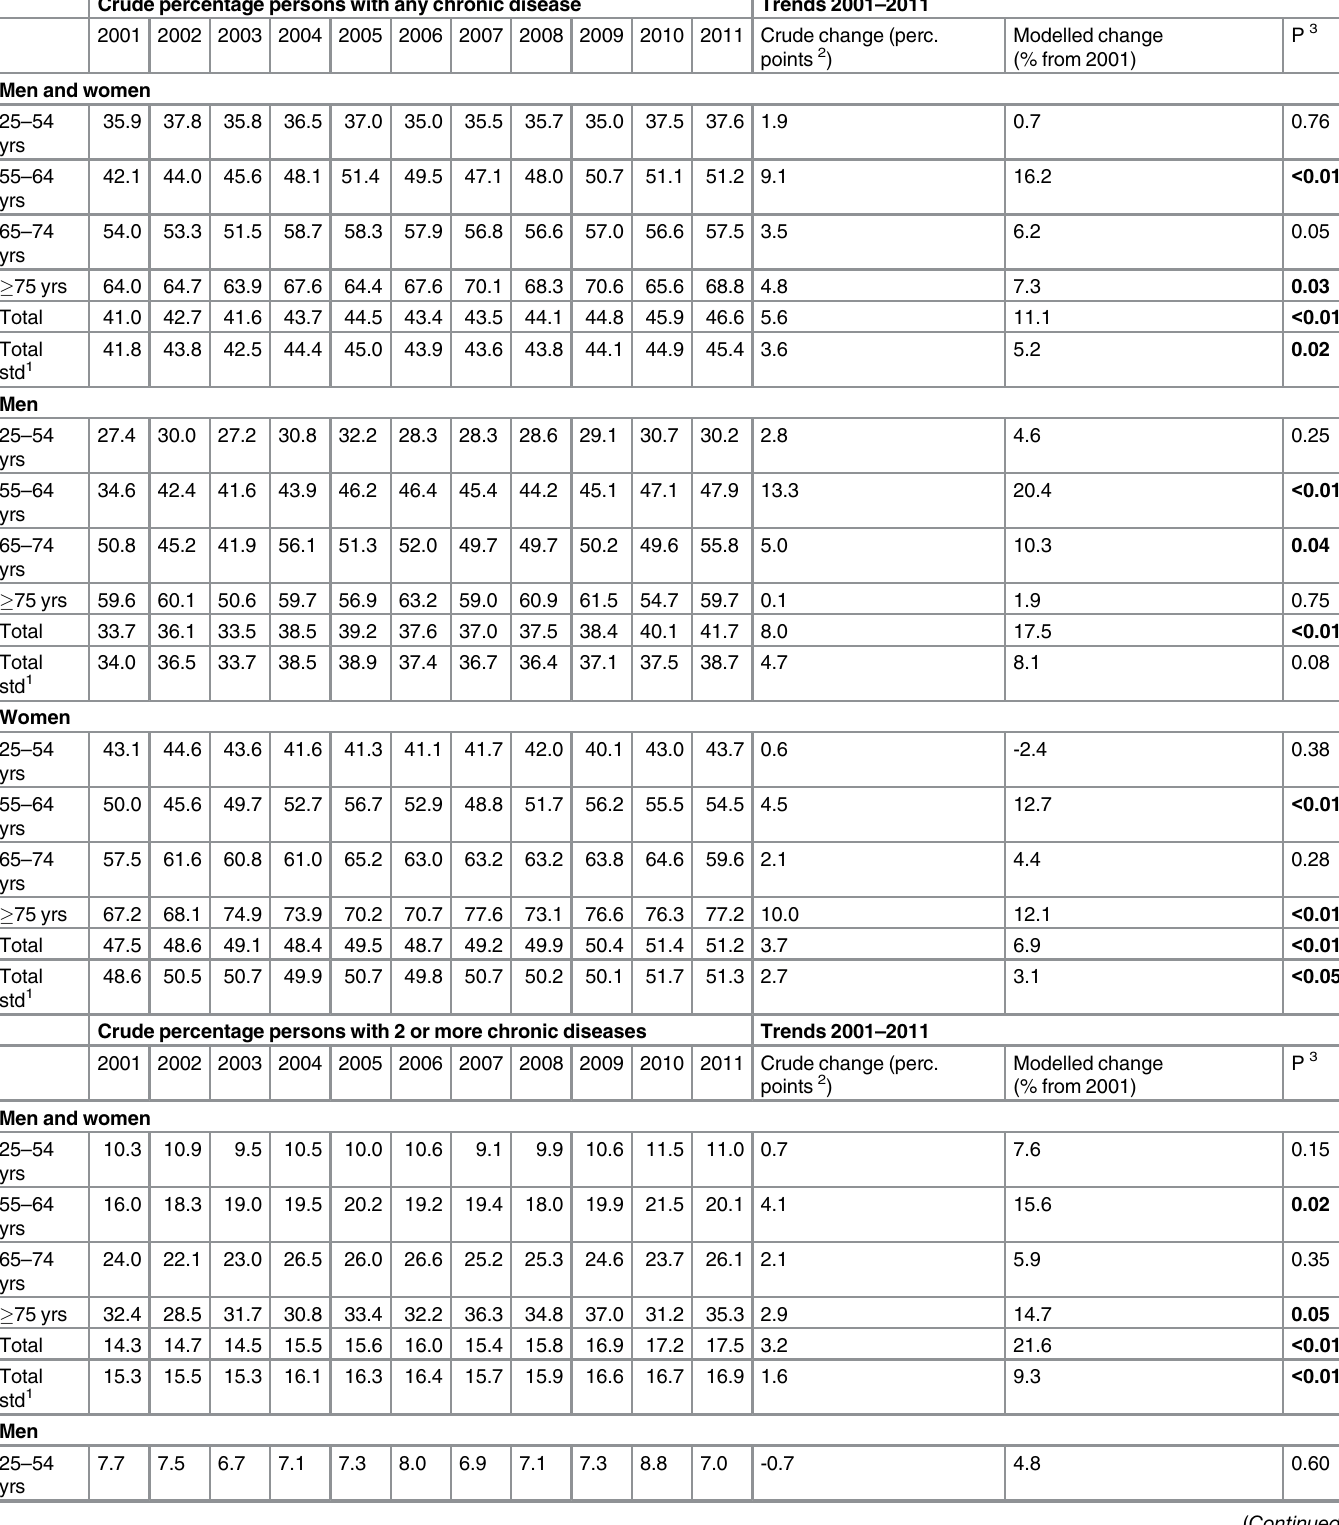
Table 2. Trends in the prevalence of self-reported chronic diseases and multimorbidity in health surveys over the period 2001 – 2011. Crude percentage persons with any chronic